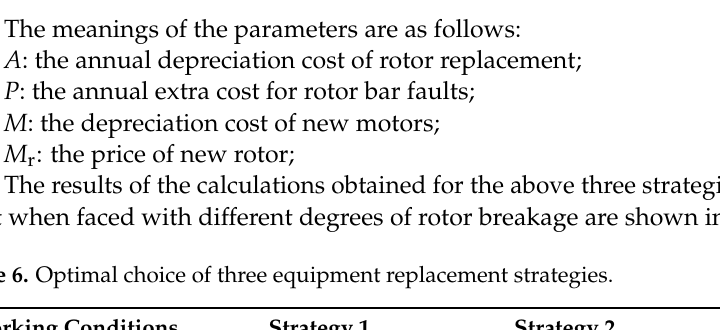
Figure 23. Flow chart of response scheme selection for BRB fault.